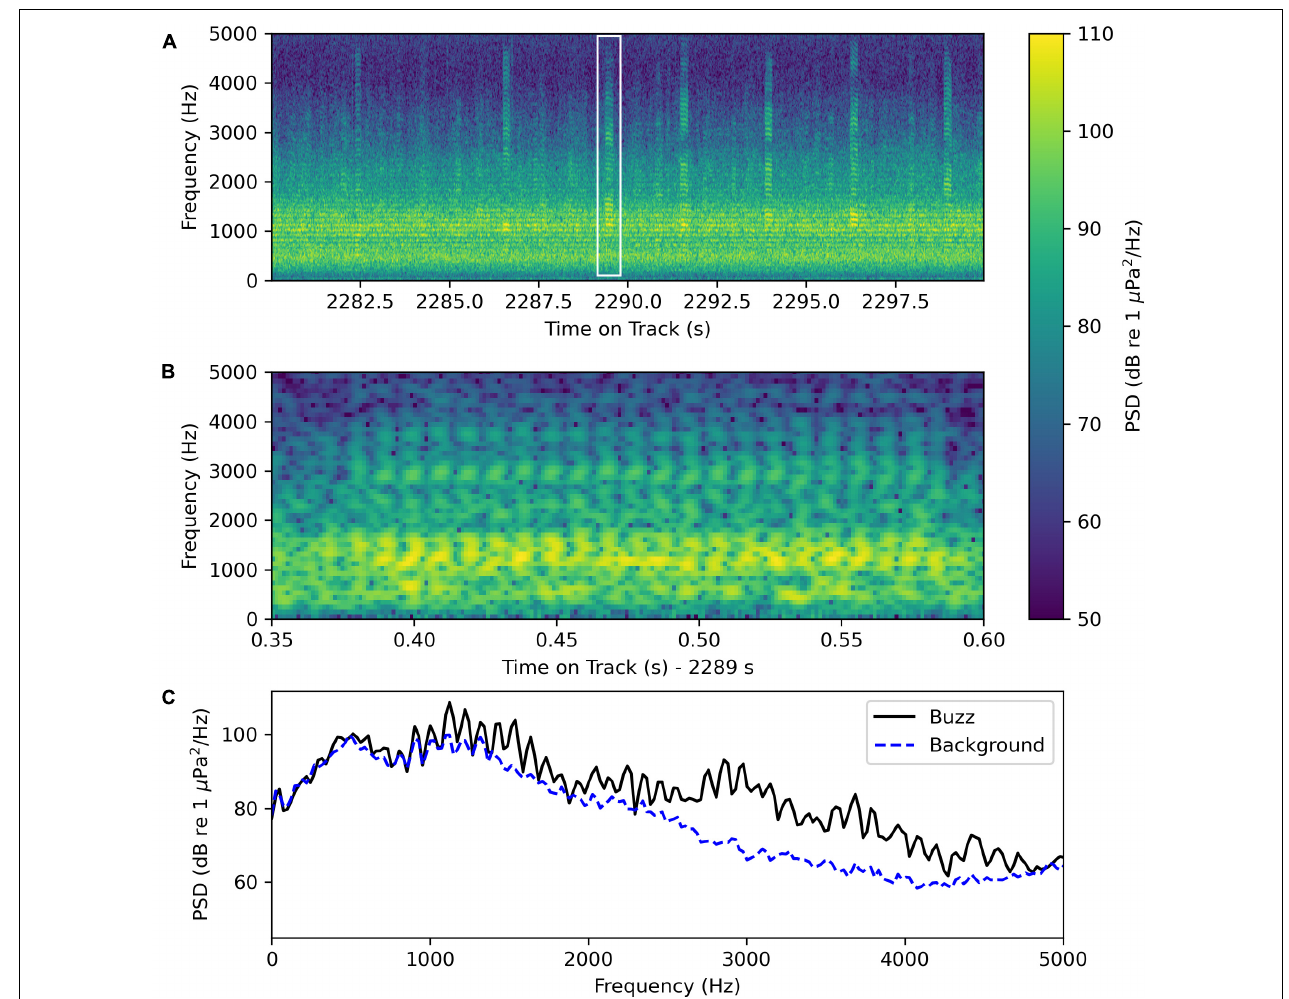
FIGURE 11 | Unknown “buzz” sound recorded by the wave glider Blackbeard at August-02 00:16:23 at latitude and longitude (34.550 280N, 76.649 032W) ( Supplementary Sound Clip Audio 4 ). (A) Spectrogram of a 20 s segment containing several distinct “buzz” calls. The in the white rectangle indicates the region on the plot that was analyzed in the next panel (B) . (B) Spectrogram of the “buzz” call in the rectangle in panel (A) using a 512-point FFT for greater time resolution. (C) Average power spectrum of the “buzz” sound shown in panel (B) was taken from 2289.35 to 2289.60 s and the average power spectrum of the background sound was taken from 2289.60 to 2290.00 s when no distinct “buzz” sounds were detected. Both average power spectra were computed using 2048-point Hanning windows with overlaps of 1024